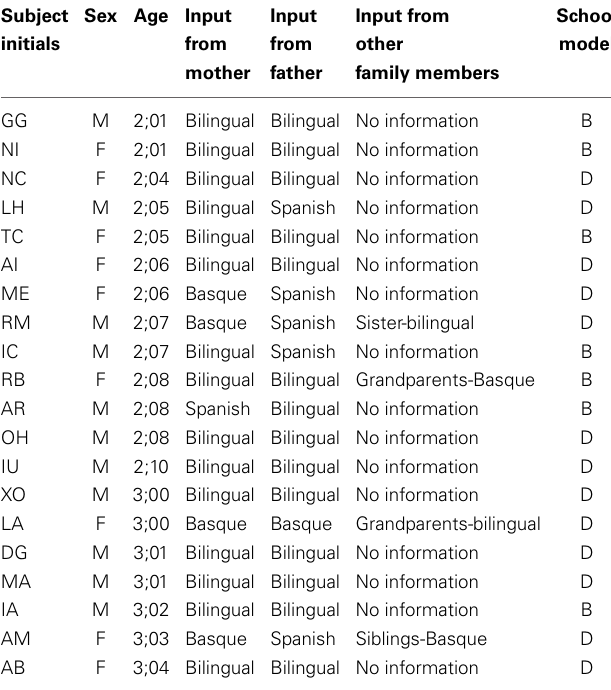
Table 3 provides the age and MLU of the 20 bilingual